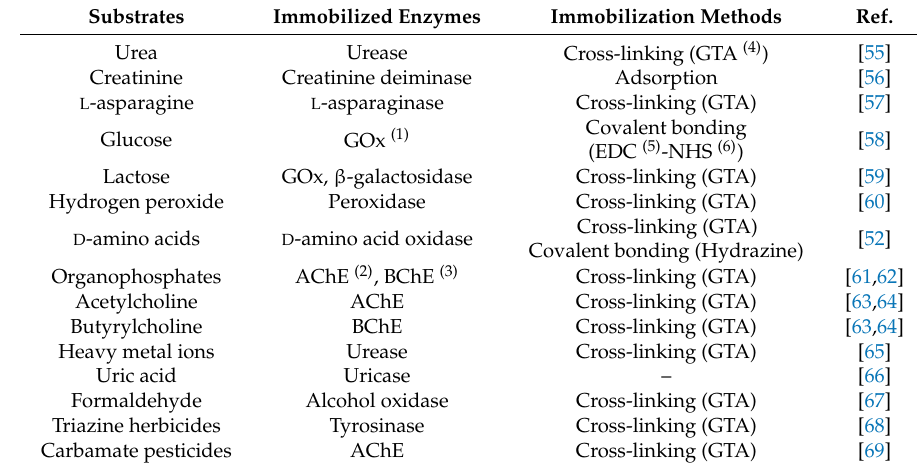
Table 1. Summary of substrates, immobilized enzymes, and immobilization methods of conductometric enzyme